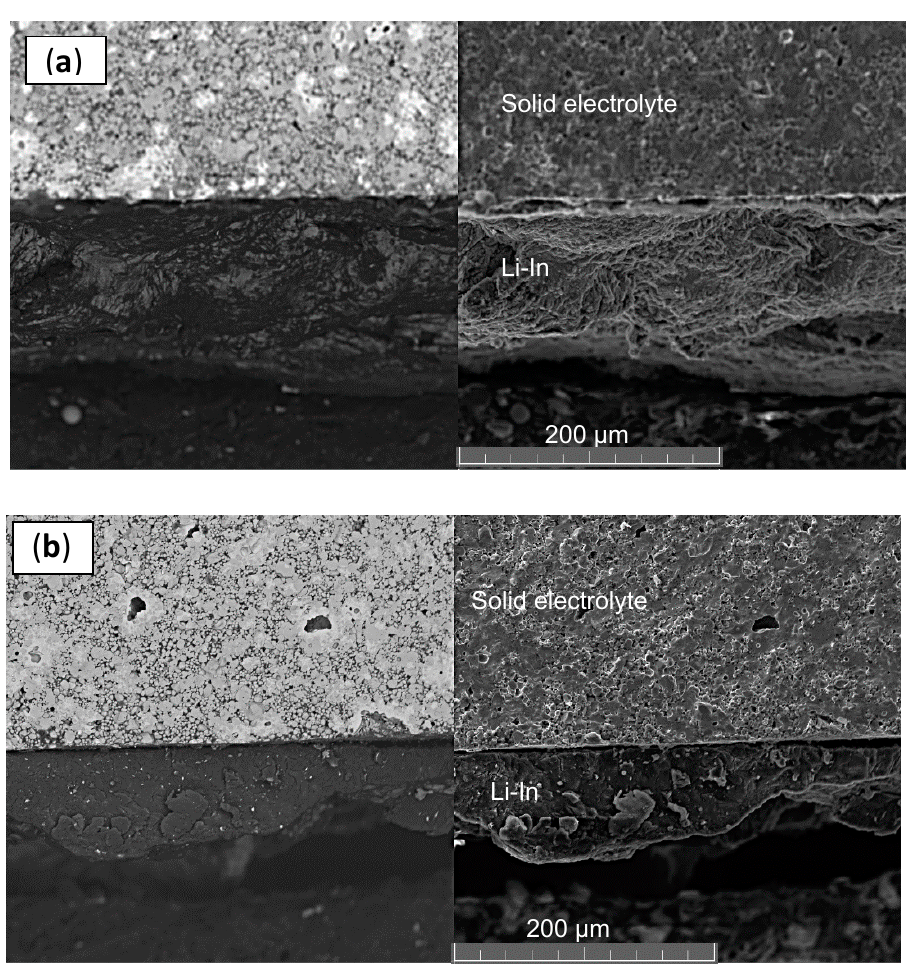
Figure 8. SEM images of the cross-section of Li-In | LLZcomp | Li-In cells with 40 ( a ) and 90 ( b ) at% Li.